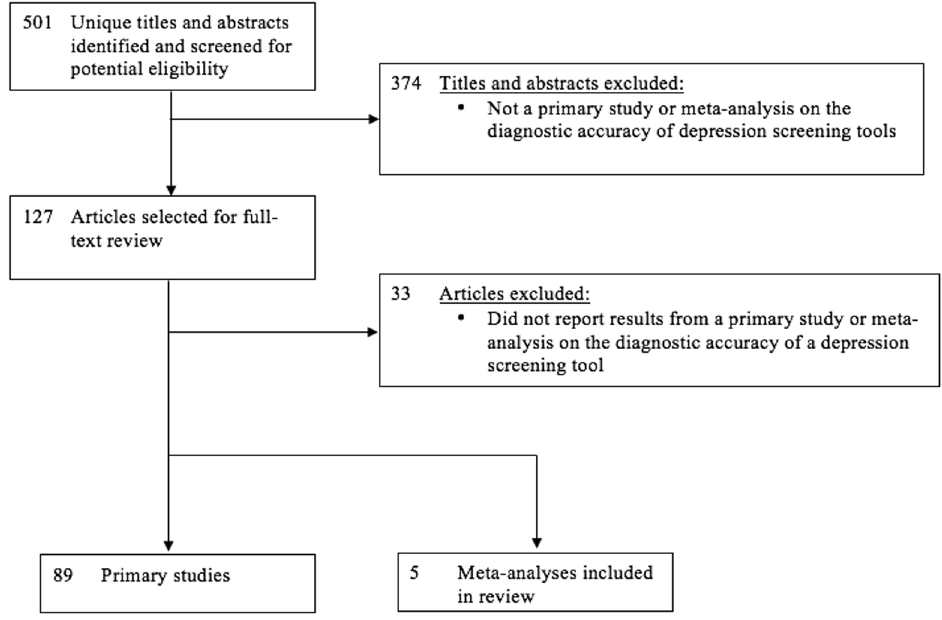
Fig 1. Flow Diagram of Selection of Primary Studies and Meta-analyses that Evaluated the Diagnostic Accuracy of Depression Screening Tools.